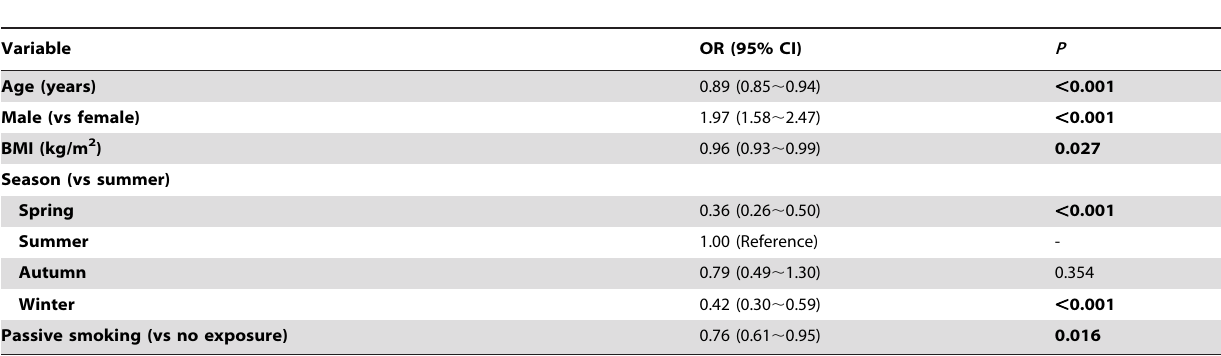
25(OH)D, 25-hydroxyvitamin D; OR, odds ratio; BMI, body mass index. *Serum 25(OH)D levels were categorized into 3 ordinal categories of vitamin D status: , 20, 20–29.9, and 30 ng/mL. The reference group for each variable is given